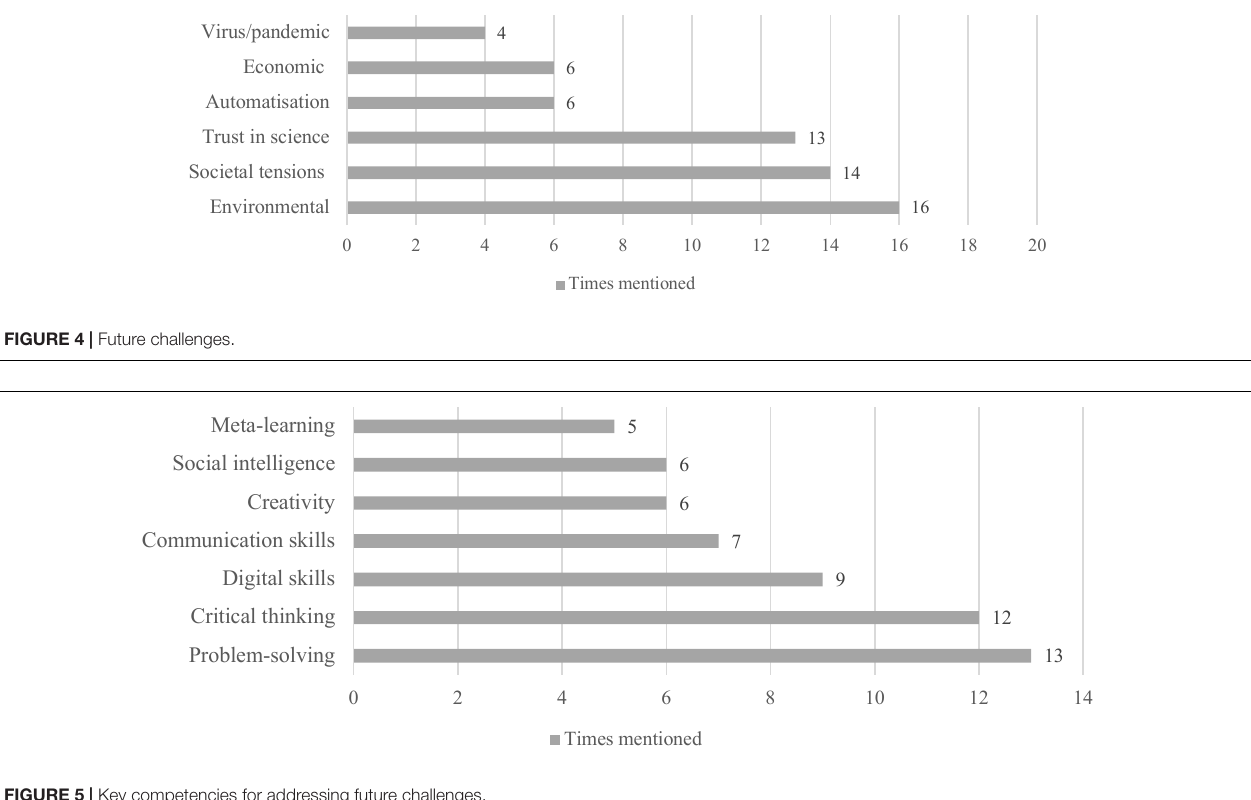
FIGURE 5 | Key competencies for addressing future